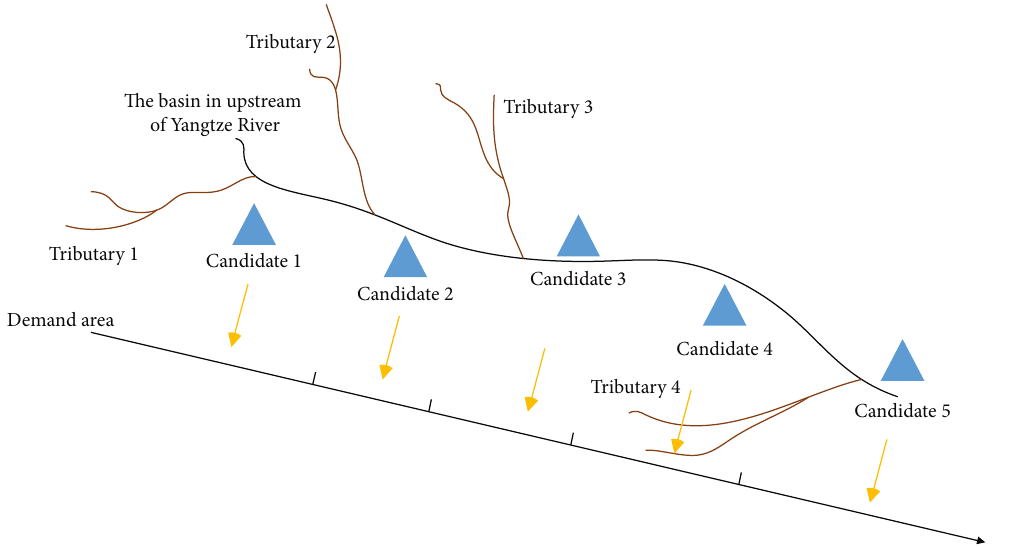
Figure 6: Illustration of hydropower station candidate in upstream of Yangtze river. Table 3: Related parameters of hydropower station candidates.